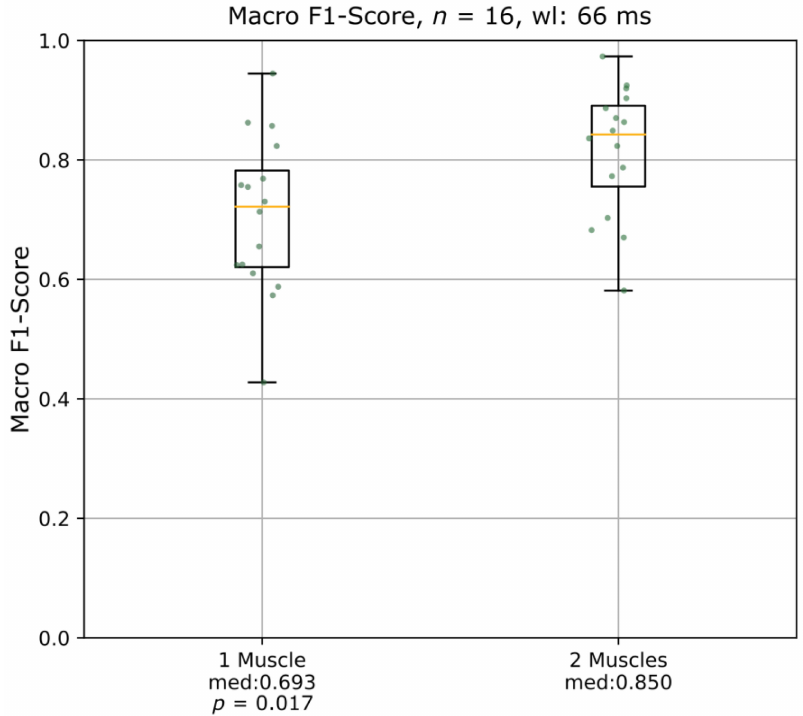
Figure 3. Boxplots of the comparison of the effect on the macro F1-scores using the electromyography of one muscle or of two muscles with a window length of 66 ms. wl = window length; med = median macro